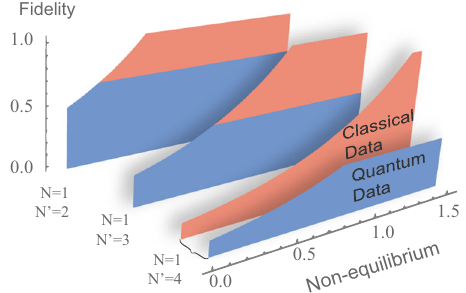
Fig. 2 | Maximum cloning fi delity for a given amount of nonequilibrium resources. The optimal accuracy-nonequilibrium tradeoff is depicted for N ! N 0 cloning machines with N =1 and N 0 =2,3,4. The fi delities for copying classical (red region) and quantum data (blue region) are limited by the same boundary curve, exceptthatthe fi delity for the task of copying quantum data cannot reach to 1 due to the no-cloning